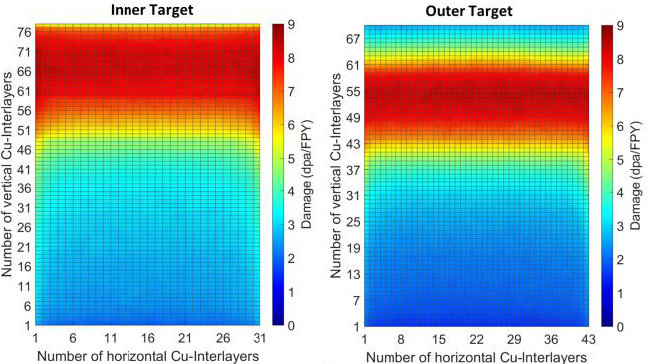
Figure 19. Nuclear damage (dpa/FPY) distribution on Cu/CuCrZr components of the inner ( left ) and outer ( right ) target, with WCLL blanket.